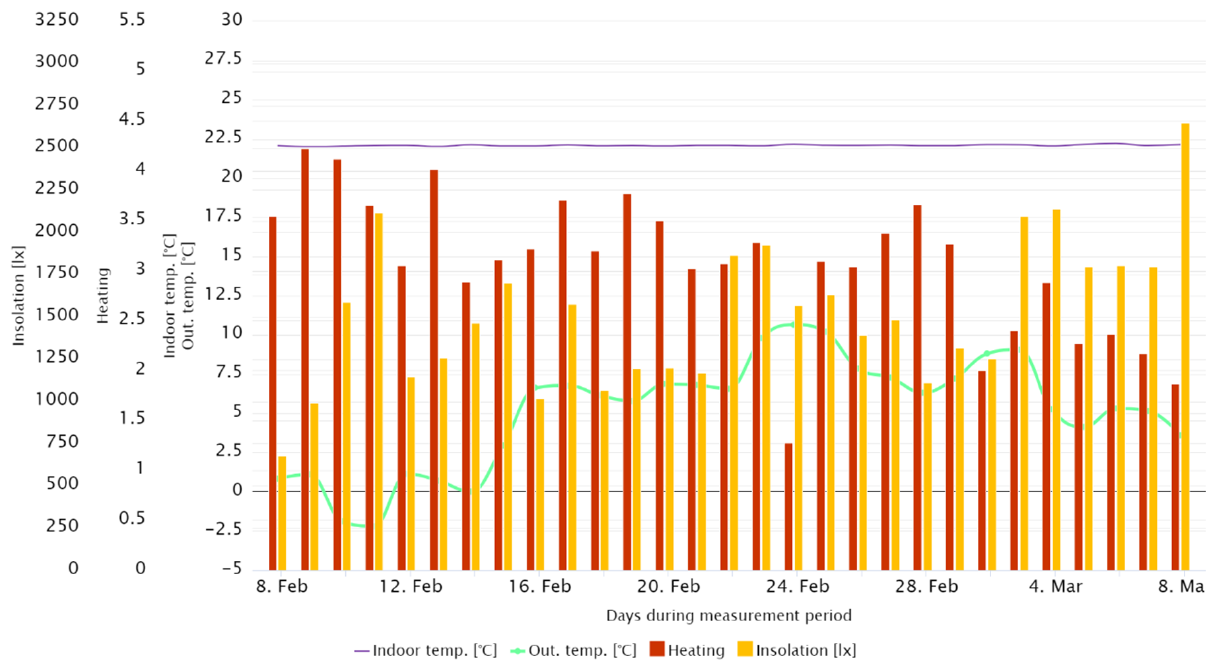
Figure 6. Daily averages of the internal temperature for room 220 referring to heating valve position, insolation, and outdoor temperature.